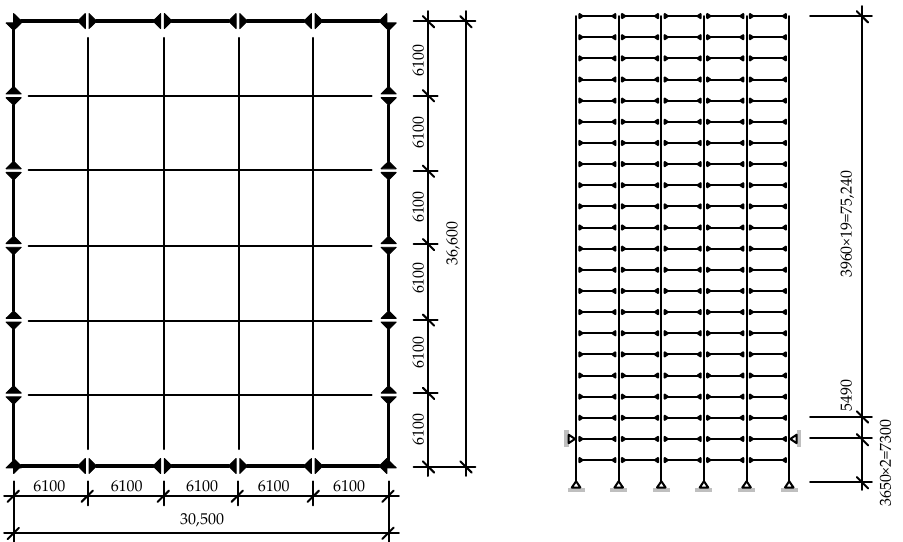
Figure 5. Floor and elevation of the demonstration frame.